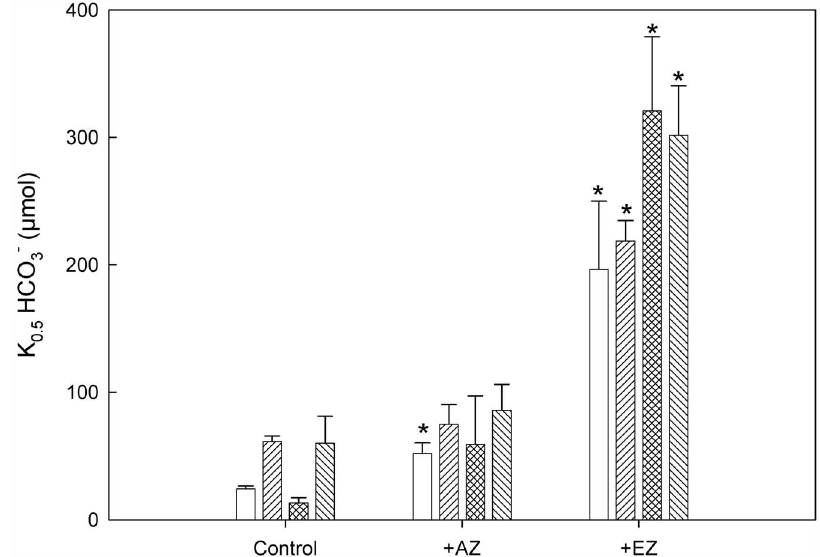
Figure 4. Change in the Michaelis constant, K 0.5 , determined as in Fig. 3 from the Michaelis-Menten equation. Legend for bars as in Fig. 3. Error bars denote SE. n=4–6. * above a bar indicates a significant change as compared to the control using a student’s t-test and p , 0.05.